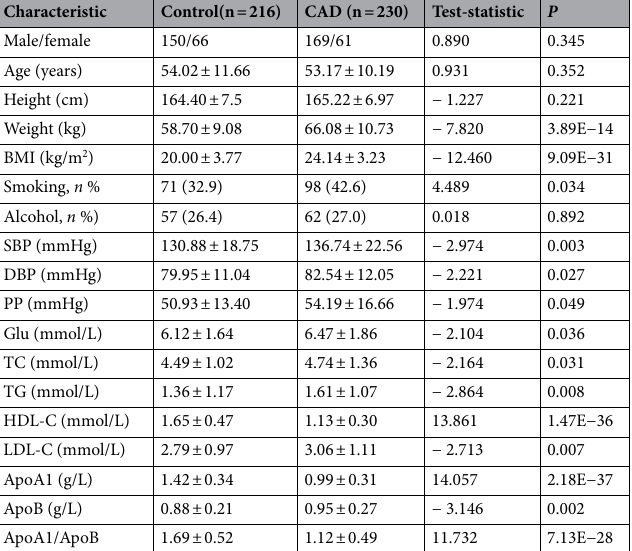
Table 2. Comparison of demographic, lifestyle characteristics and serum lipid levels of the participants. SBP Systolic blood pressure; DBP Diastolic blood pressure; PP Pulse pressure; Glu Glucose; HDL-C high-density lipoprotein cholesterol; LDL-C low-density lipoprotein cholesterol; Apo Apolipoprotein; TC Total cholesterol ; TG Triglyceride. a Continuous data were presented as means ± SD and determined by two side t -test. b A Chi- square analysis was used to evaluate the difference of the rate between the